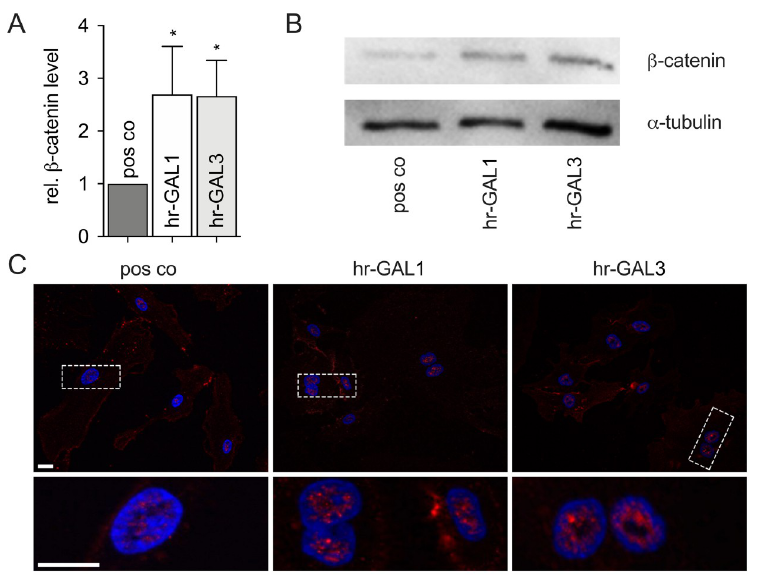
Fig 9. Hr-GAL1 and 3 activate Wnt/ β -catenin signaling in HRMEC in vitro . A, B. Western blot analysis (B) and densitometry (A) for β -catenin on proteins from HRMEC after incubation with 120 μ g/ml hr-GAL1 or 3 for 24 h ( � co vs hr-GAL1: p = 0.019, � Co vs hr-GAL3: p = 0.021) � p < 0.5; n = 3 of 3 independent experiments. C. Immunofluorescent staining for β -catenin (red) after incubation with 120 μ g/ml hr-GAL1 or 3 for 24 h. Magnification bars, 20 μ m; blue, Hoechst